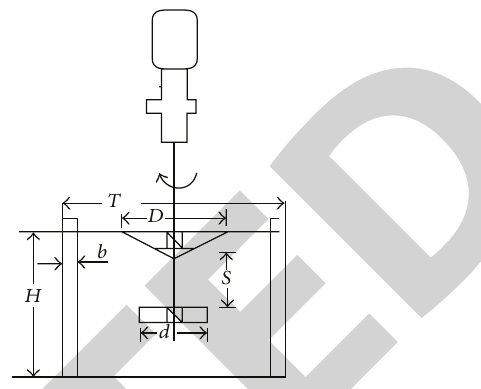
Figure 1: The schematic diagram of the experimental